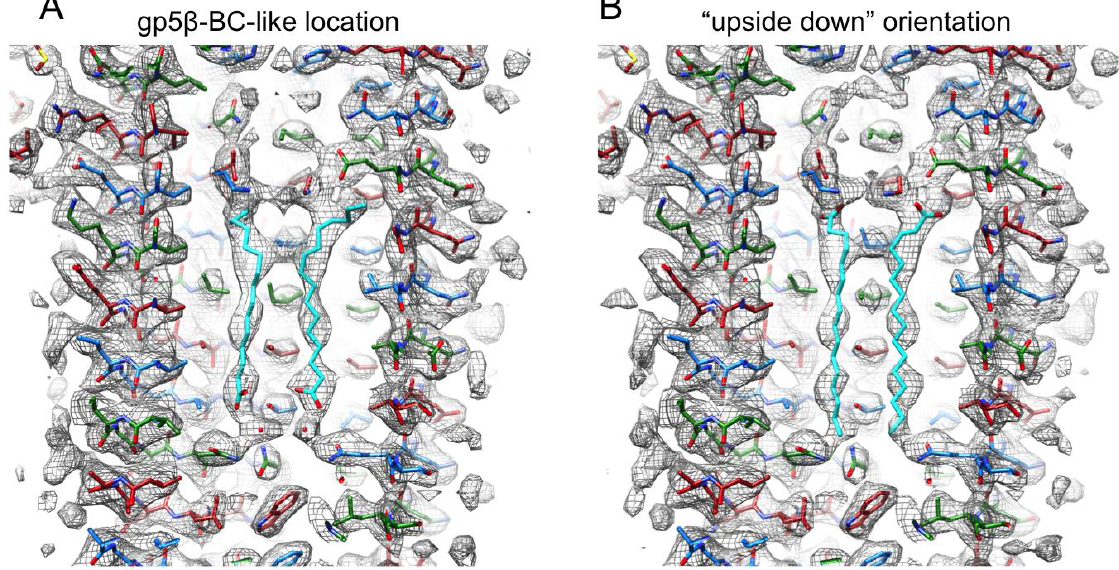
Figure 12. Fit of the palmitic acid molecule into the electron density of the full-length gp5 protein (PDB ID 1K28). ( A ) The location and orientation of the palmitic acid molecule are similar to those in the gp5 β -BC structure; ( B ) The palmitic acid molecule is in an “upside down” orientation. Both 2Fo-Fc maps are contoured at 1.0 standard deviations above the mean. The color scheme is as in Figure 5B.